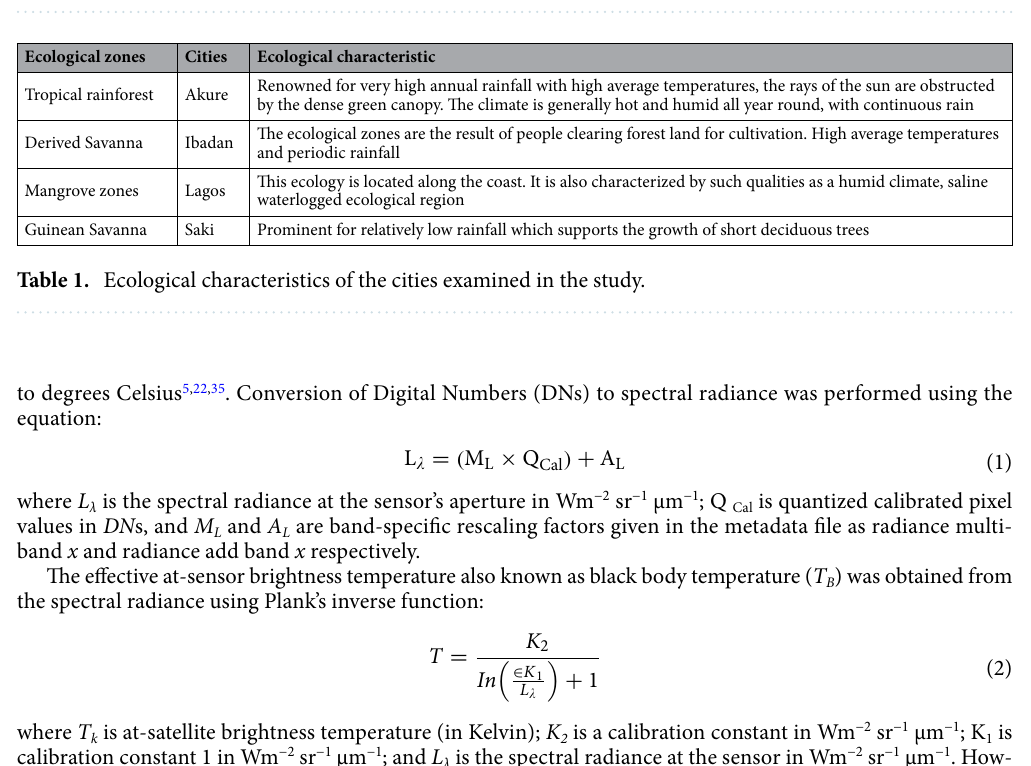
Figure 1. Map of the study area showing the location of four cities examined in the study. The figure was generated using ArcGIS 10.5 software (http:// www. esri. com/).